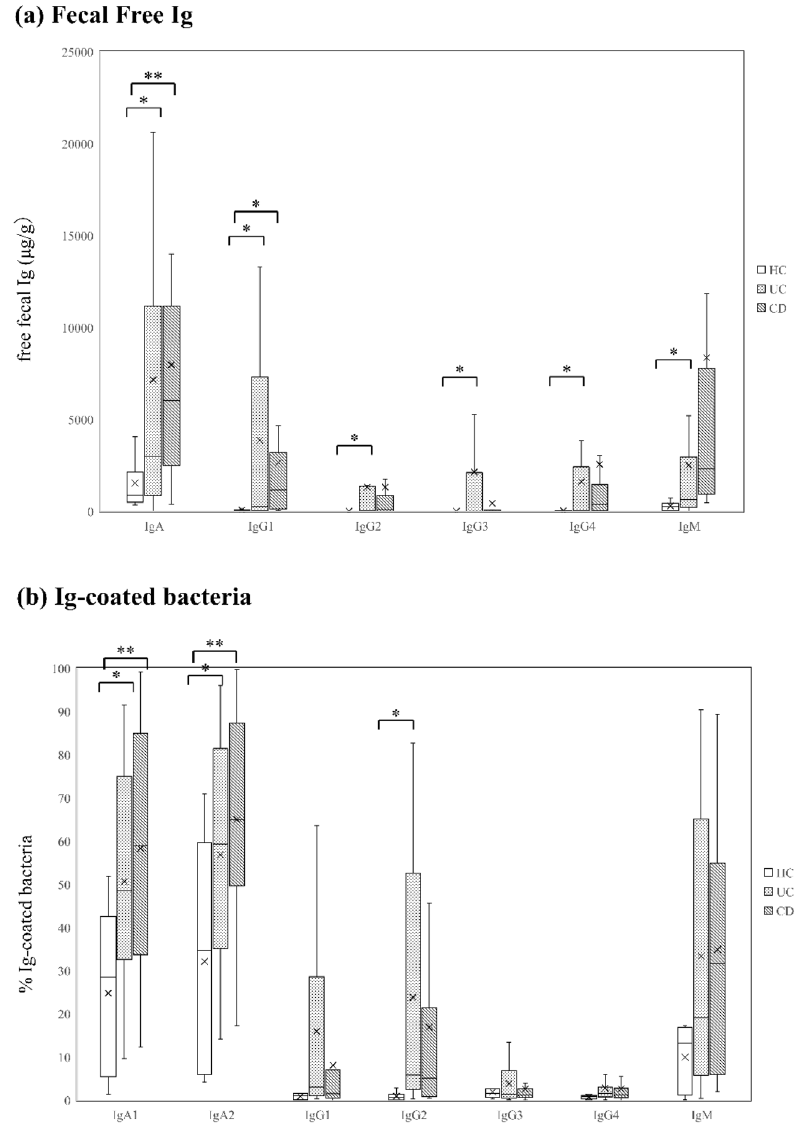
Figure 1. Free Ig and Ig-coated bacteria in fecal samples obtained from patients with IBD and HCs. ( a ) Box plot showing the concentration of fecal free Ig from HCs (n = 12), UC patients (n = 20), and CD patients (n = 22). The median (the bars in the boxes) concentrations of fecal free Ig are shown. ( b ) Box plot showing the flow cytometry analysis results for the ratio of each Ig-coated bacteria from HCs (n = 11), UC patients (n = 19), and CD patients (n = 21). The median (the bars in the boxes) concentrations of fecal free Ig are shown. The brackets indicate significant differences (Wilcoxon rank-sum test. p -values are shown * < 0.05, **< 0.005. The student’s t -test. p -values are shown † < 0.05, †† < 0.005). HC Healthy control, UC ulcerative colitis, CD Crohn’s